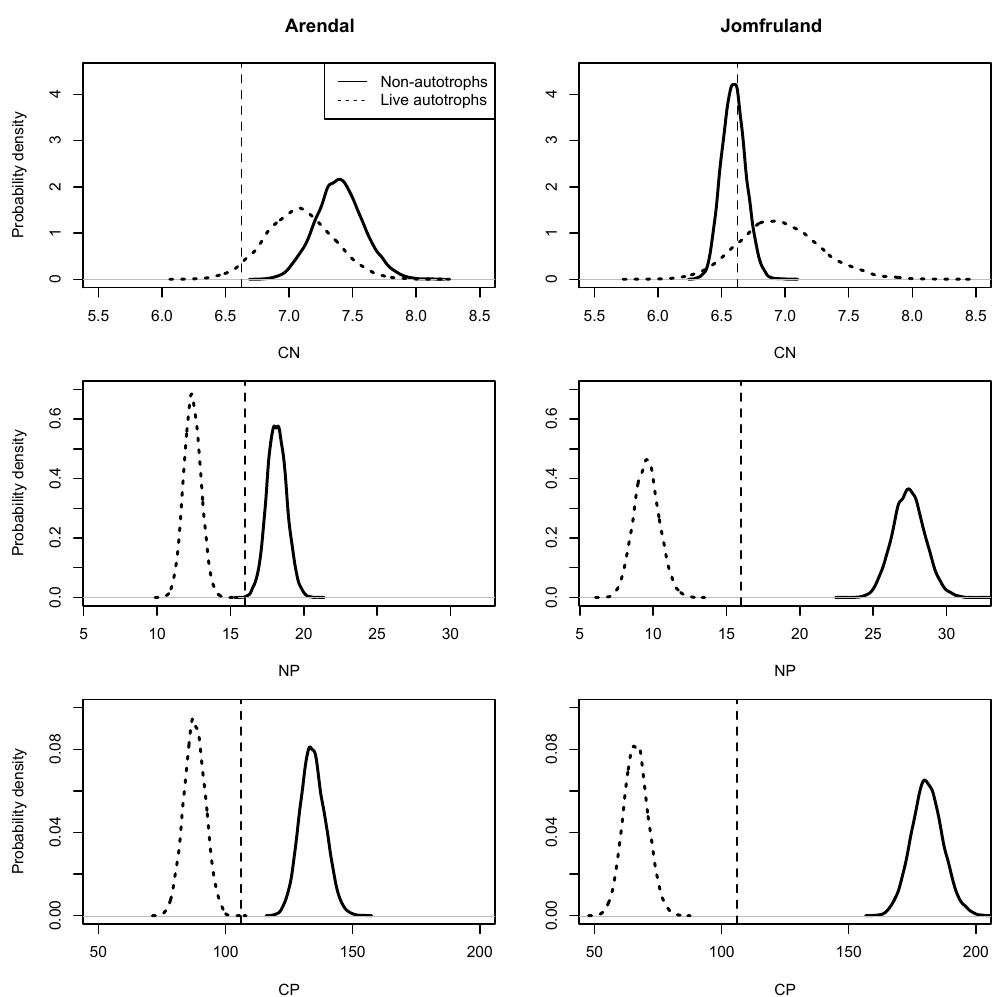
Fig. 12. Probability densities of C:N, C:P and N:P for the live autotrophic and non-autotrophic fractions calculated with the regression model, for information on bootstrapping procedures see Sect. 2.3. The stippled vertical lines indicate the Redfield